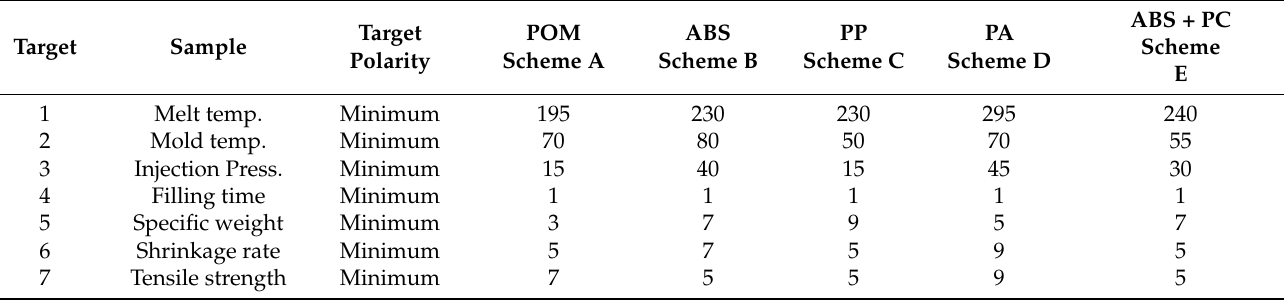
Table 8. Sample of material evaluation criteria.